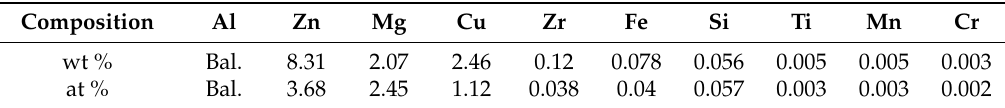
Table 1. Chemical composition of studied Al-Zn-Mg-Cu-Zr alloy samples. Composition